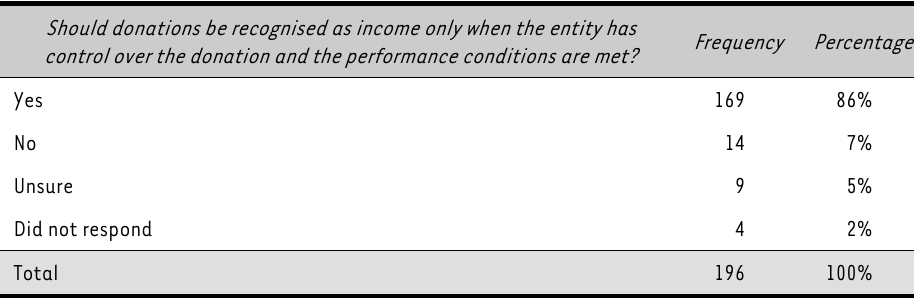
Recognition of restricted